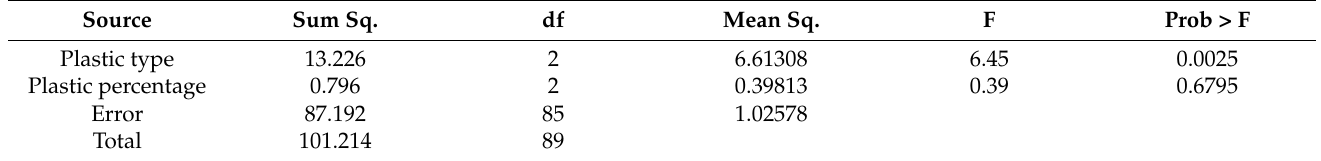
Table 5. The results of using ANOVA to verify the statistical significance of the impact of plastic type and plastic percentage on the maximum width of the damage zone on the drill exit side ( W 2 (mm)).